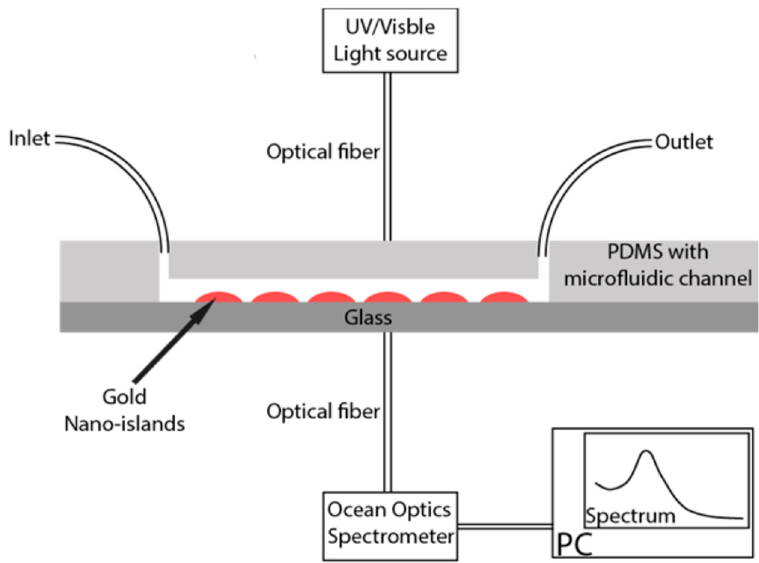
Figure10. Schematicofthemicrofluidicdevicewithnano-islandstructures(reproducedwithpermission Figure 10. Schematic of the microfluidic device with nano-island structures (reproduced with from Int. J. Biomed. Biol. Eng. permission from Int. J. Biomed. Biol. Eng. [50]).